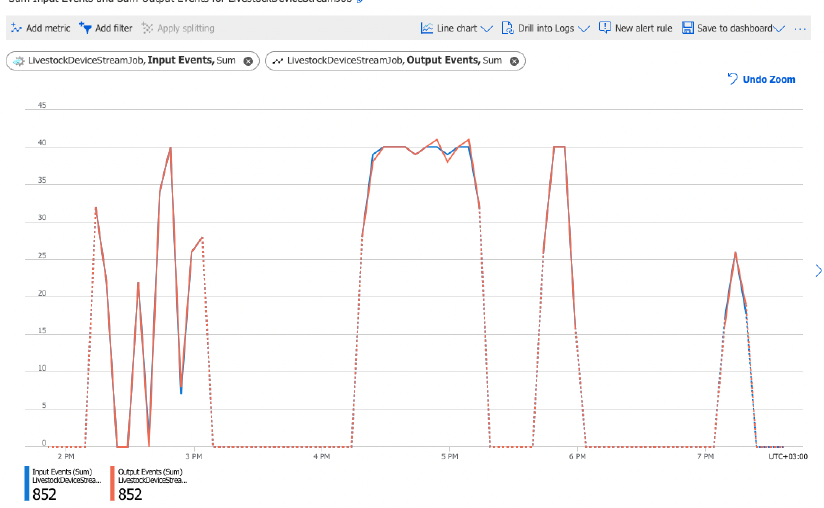
Figure 9. Sum input events and sum output events for livestock device stream job per day. The blue line shows the sum of input events. The Red line shows the sum of output events. The dotted line shows that no data is ingested for that period (when IoT devices are in sleep mode).